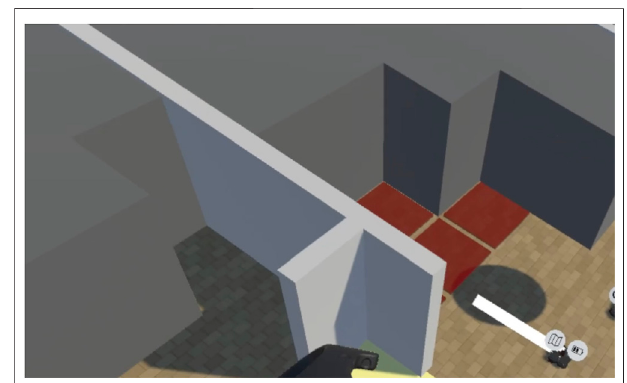
FIGURE 4 | “ Fog of war ” is displayed as the dark grey opaque blocks. These areas represent the parts of the map that have not been veri fi ed by an Explorer